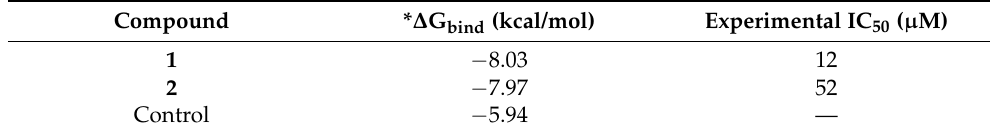
(Table 2). The ability of AutoDock 4.2 to repose the co-crystallized structure and reserve the key interactions with ARG171 (guanidinium side chain), HIS195, and ALA236 is remarkable as ARG171 is known to be highly conserved in the active site [33]. Table 2. The docking scores for compounds 1 , 2 , and the co-crystallized ligand (3,5-dihydroxy-2- naphthoic acid) in the active binding site of Pf LDH (1U5A.PDB) using AutoDock 4.2.